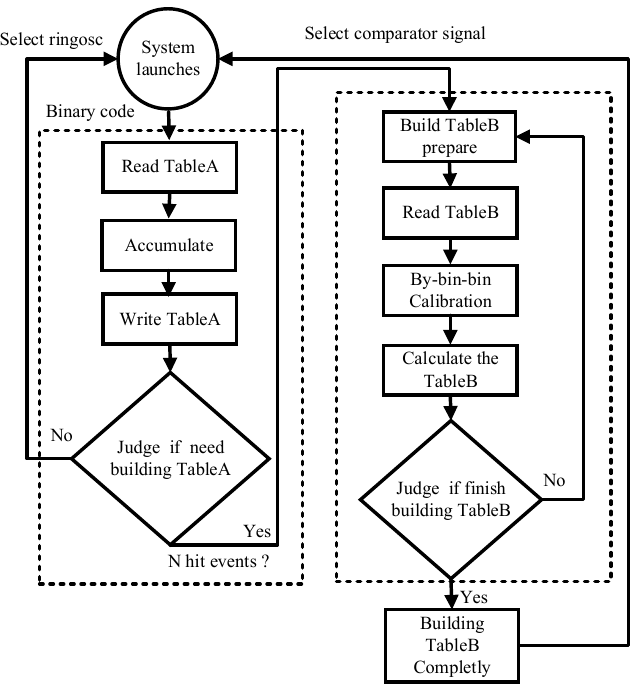
Figure 9. Flow chart of the bin-by-bin calibration.